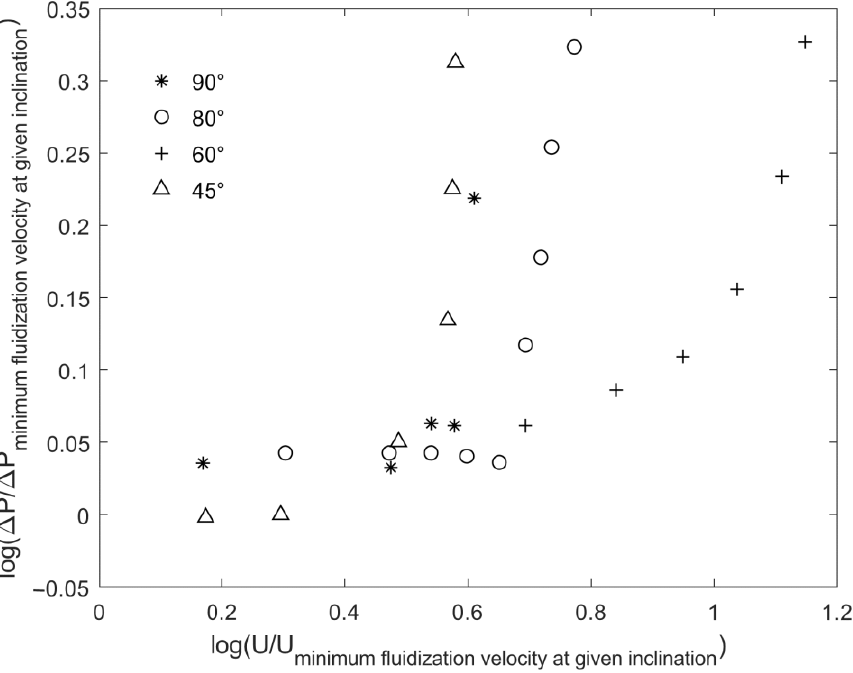
Figure 3. Yakubov et al. re-plotted as relative pressure drop as a function of relative superficial velocity for each inclination.